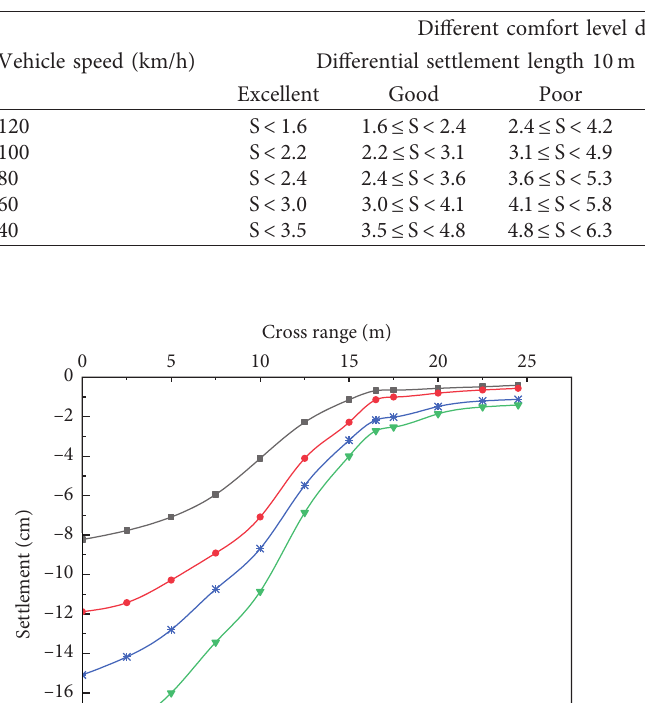
Table 9: Differential settlement control standards based on driving comfort.